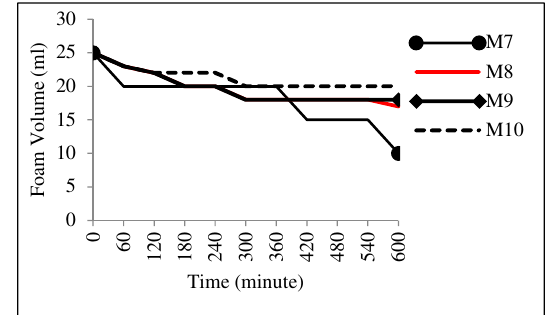
FIG. 4. GENERATED FOAM VOLUME AND ITS STABILITY BY SURFACTANT SOLUTION OF FIG. 3. GENERATED FOAM VOLUME AND ITS M7, M8, M9 AND M10 STABILITY BY SURFACTANT SOLUTION OF M3, M4, M5 AND M6 Surfactant solution of M10 produced good foam volume and was stable with long time duration. The The foam volume generated from 10ml solution of M3 surfactant solution M9 produced 20ml foam, whereas, was stable with slowly decreased up to 600 minutes. M10 surfactant solution produced 22ml foam. The same foam volume was generated as foam generated by M1 and M2 surfactant solution. The foam